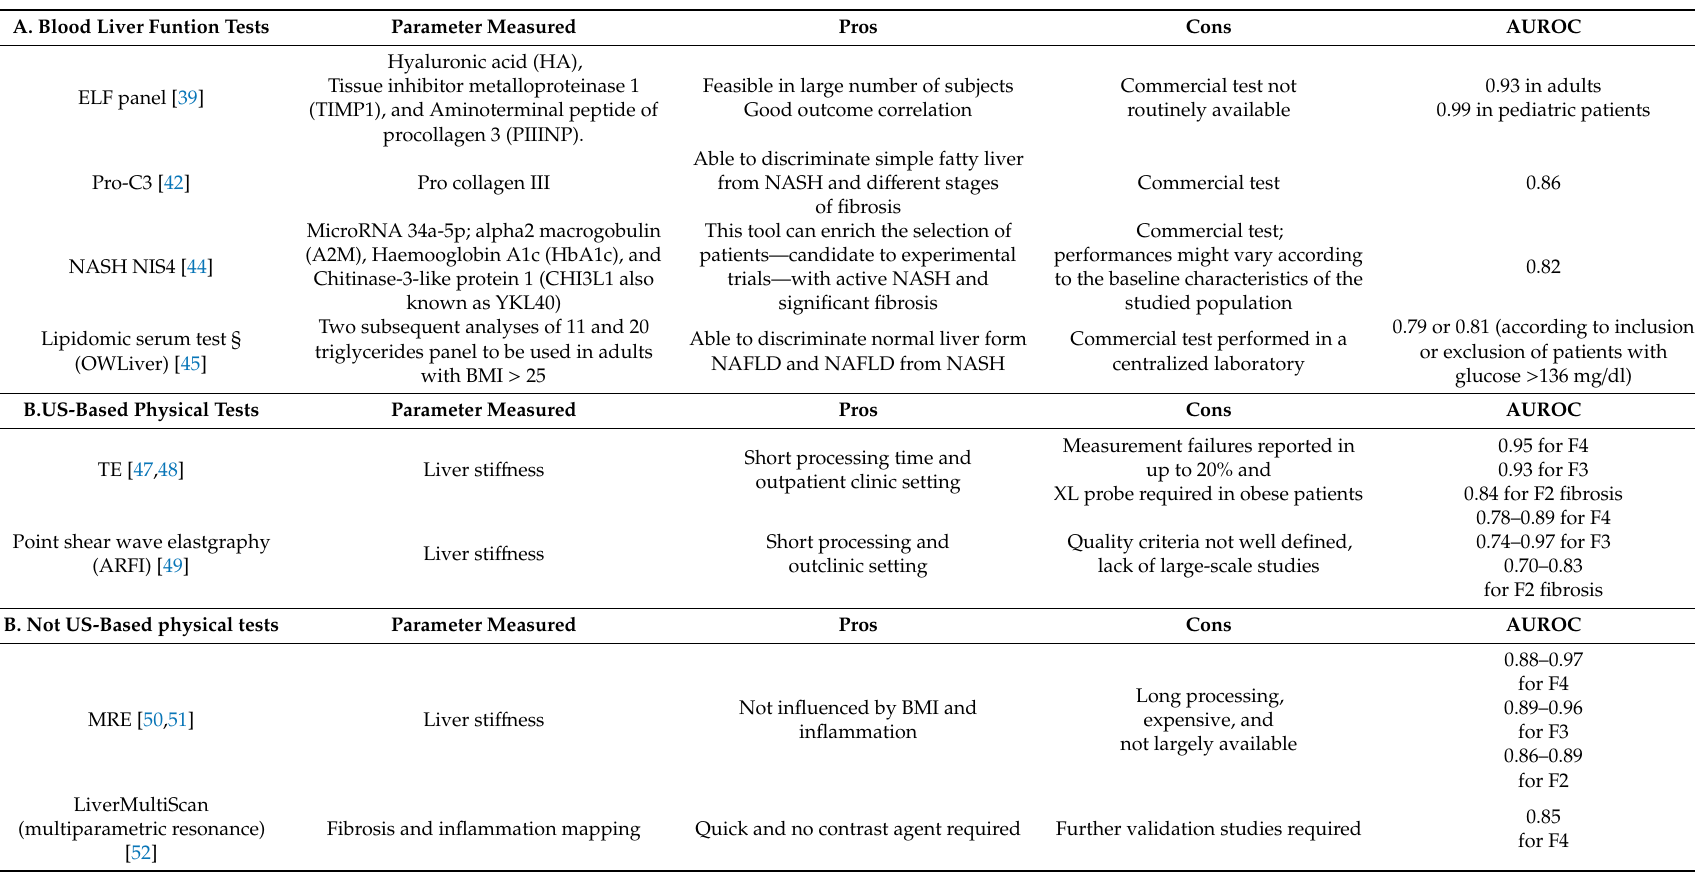
Table 1. Various emerging modalities for nonalcoholic steatohepatitis (NASH) minimally invasive / noninvasive diagnosis: (A) blood clinical biochemistry liver function tests with liver histology as comparator; (B) physical tests US-based or